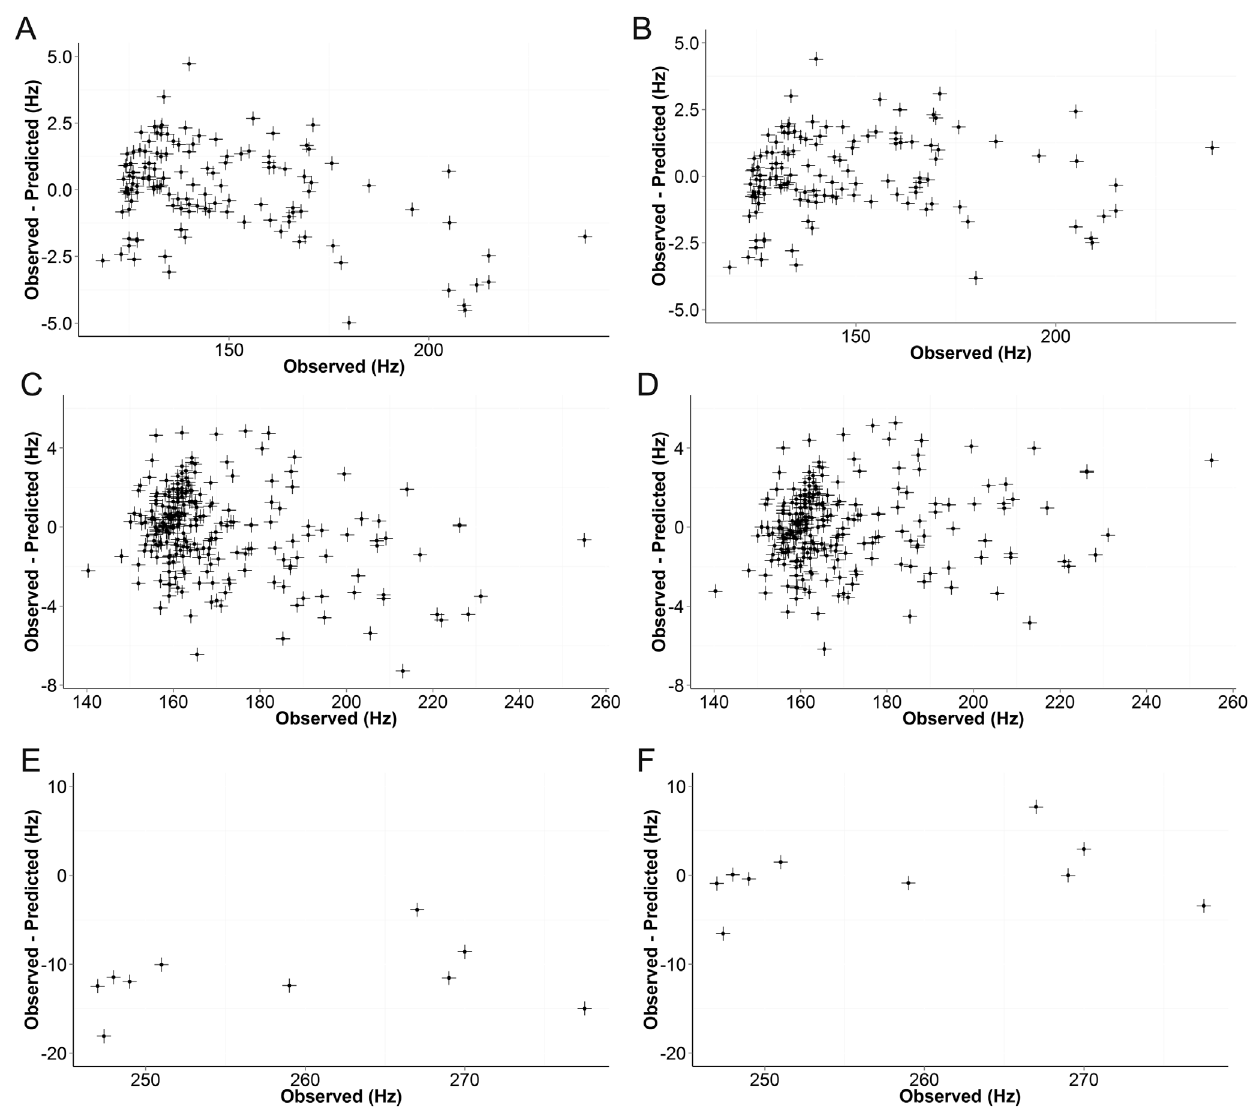
Figure 4. Plots of the difference between observed and predicted versus observed 1 J CH for different hybridization states. A: uncorrected sp 3 pairs. B: sp 3 pairs corrected by linear regression. C: uncorrected sp 2 pairs. D: sp 2 pairs corrected by linear regression. E: uncorrected sp 3 pairs. F: sp 3 pairs corrected by linear regression. Couplings identified as outliers are not shown.